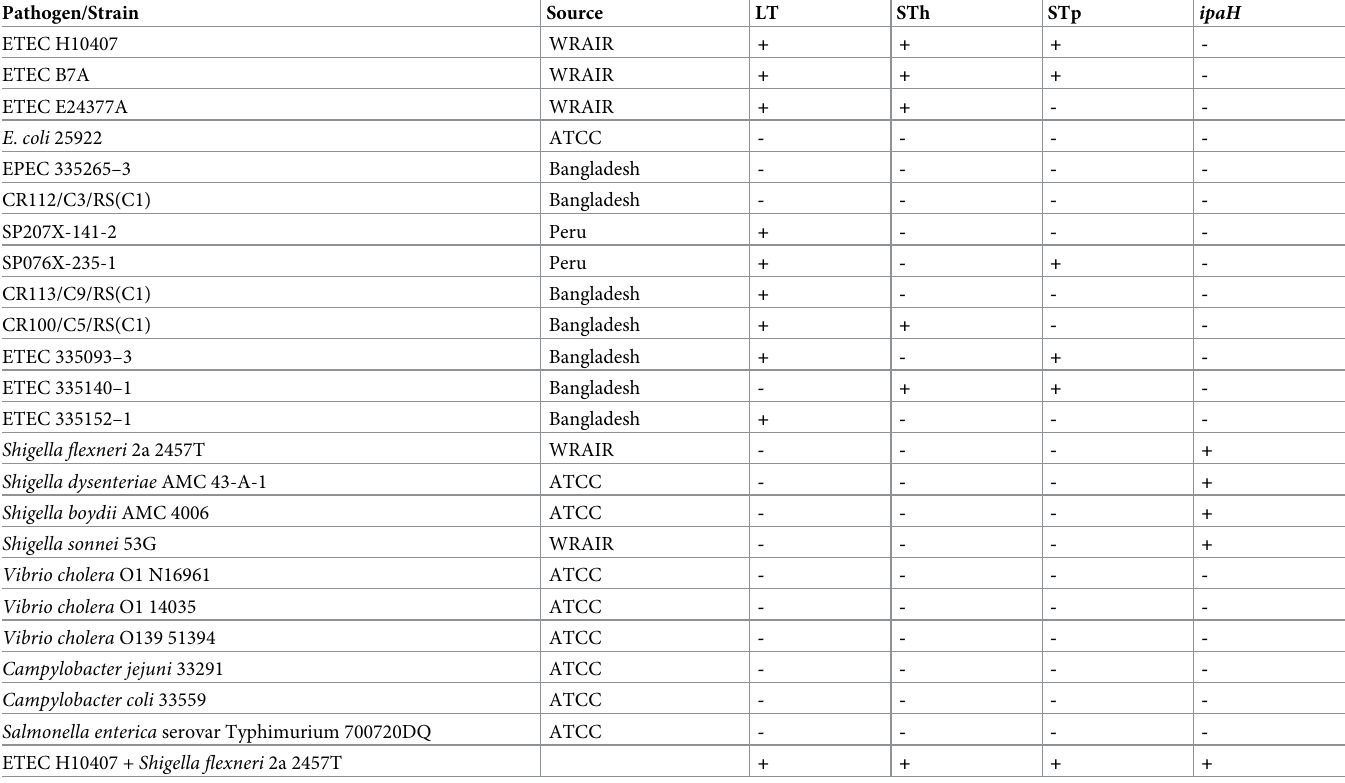
Table 2. List of strains used for the evaluation of the specificity of ETEC and Shigella RLDT.